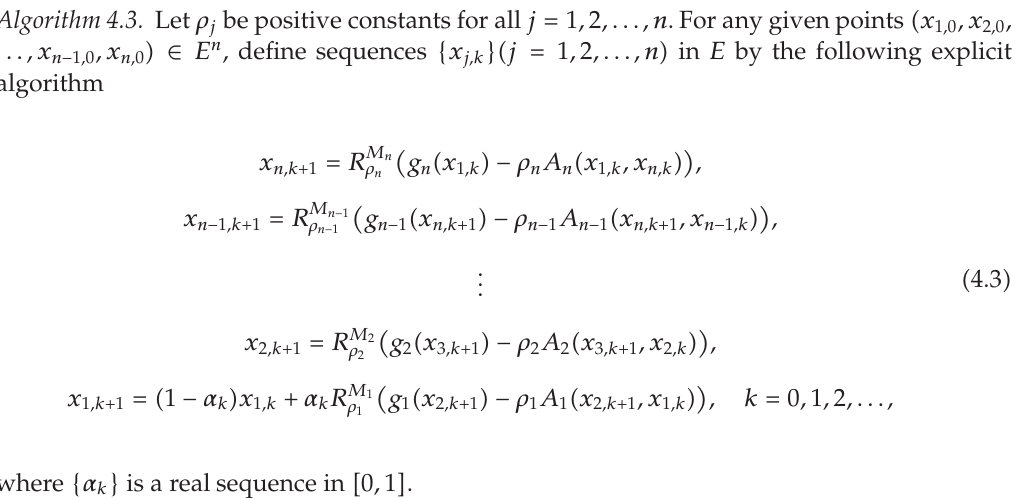
Algorithm 4.3. Let ρ j be positive constants for all j (cid:8) 1 , 2 , . . ., n . For any given points (cid:2) x 1 , 0 , x 2 , 0 , . . . , x n − 1 , 0 , x n, 0 (cid:3) ∈ E n , define sequences { x j,k } (cid:2) j (cid:8) 1 , 2 , . . ., n (cid:3) in E by the following explicit